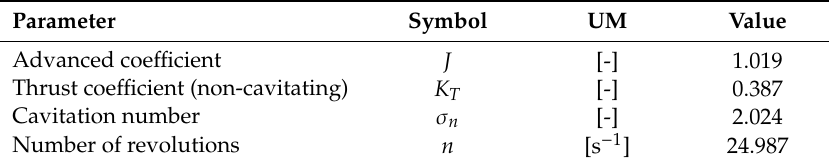
Table 10. Cavitation observations. Test case 2.3.1 in